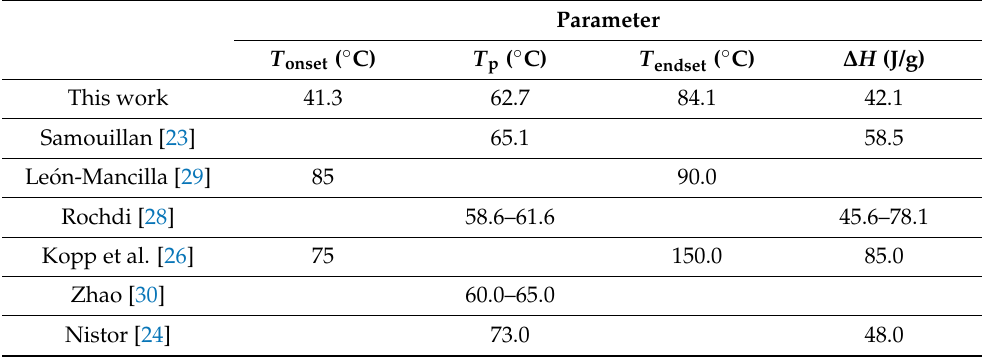
Table 5. Comparison of critical temperatures and enthalpy of the endothermic reaction of our samples with some literature